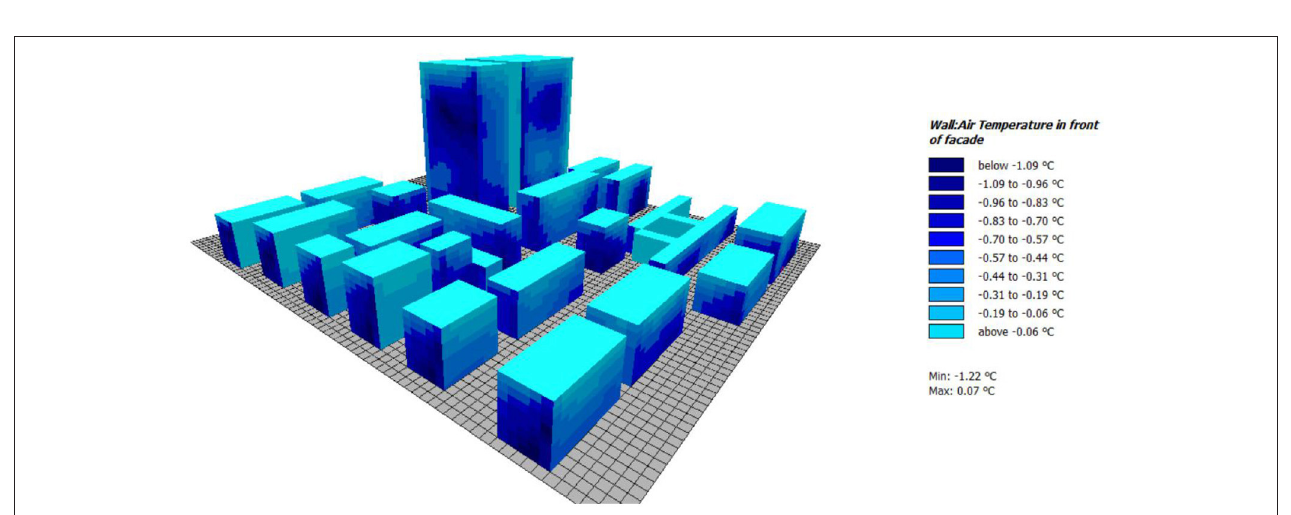
FIGURE 15 | Comparison of average 1 Ta and 1 RH with S8 and W8 in the optimization scheme (A) . Comparison of optimized schemes PET, S8, and W8 (B) .